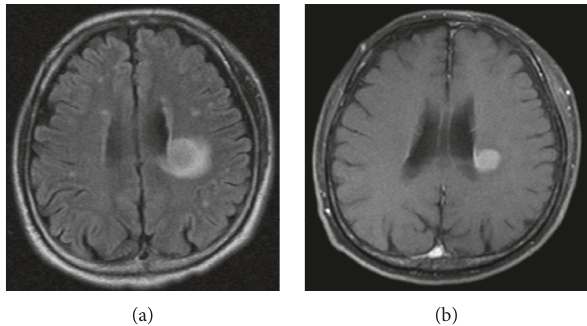
Figure 3: Magnetic resonance imaging (MRI) for CNS relapse. (a) Fluid-attenuated inversion recovery image showing a 2.3-cm mass in the infarction lesion in the white matter near the left lateral ventricle. (b) Contrast-enhanced MRI showing an evenly enhanced